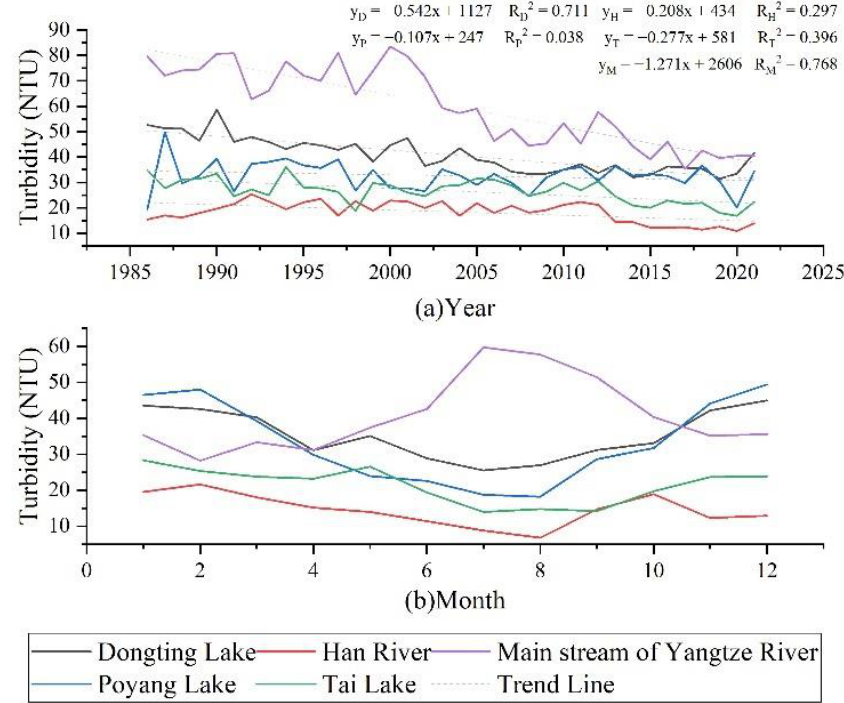
Figure 16. Variations of mean turbidity of rivers and lakes in the Yangtze River Basin from 1986 to 2021. ( a ) annual variations; ( b ) monthly variations.